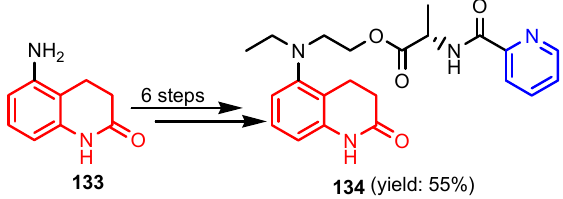
Scheme 29. Synthesis of tetrahydroquinolin-pyridine 134 [59].